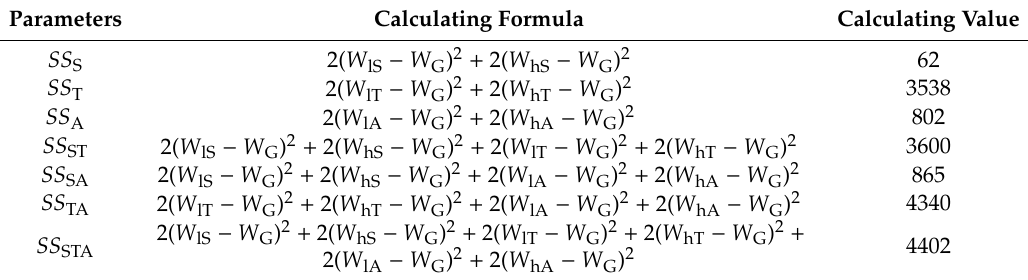
Table 6. Sum of squares for each factor and their interactions.